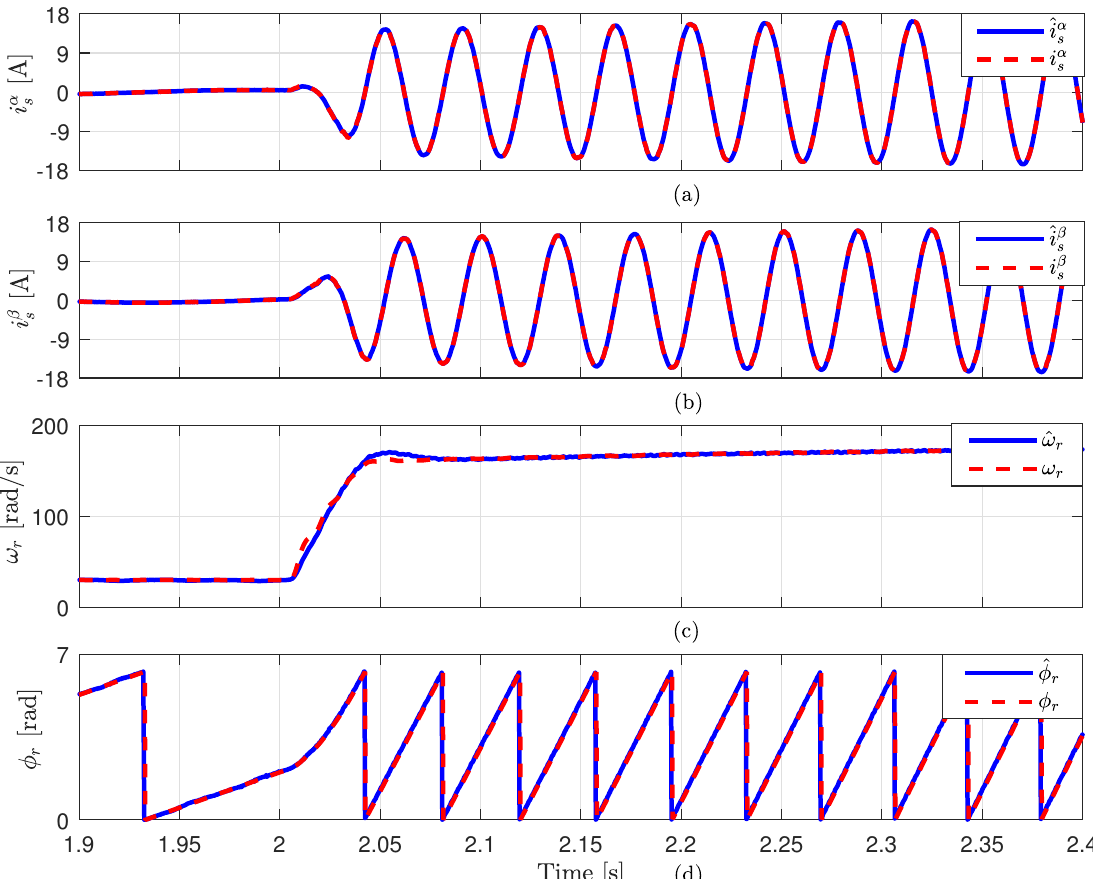
Figure 9. Estimation performance of the proposed EKF at change of the rotor speed: ( a ) Measured and estimated α -axis current, ( b ) measured and estimated β -axis current, ( c ) measured and estimated electrical angular speed of the rotor, and ( d ) measured and estimated electrical position of the